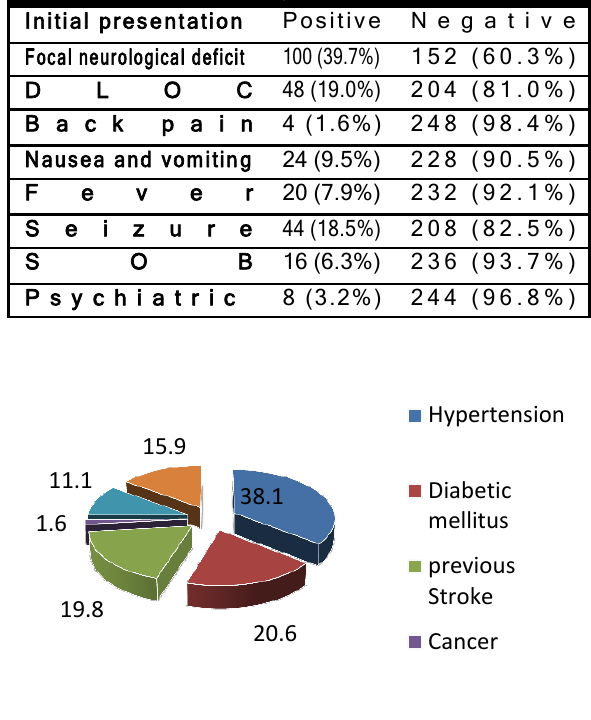
Table 3: cause of admission in patients admitted to medical wards